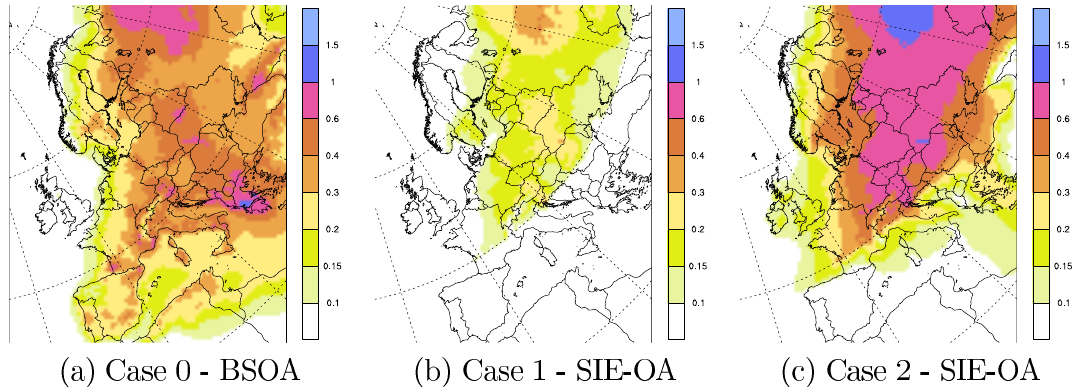
Figure 4. Model calculated 6-month mean (Apr–Sep) concentrations of BSOA and biotic stress-induced OA (SIE-OA); (a) BSOA in Case 0 (reference case without explicit stress-induced emissions), (b) SIE-OA in Case 1 (biotic stress with sesquiterpene (SQT) emissions), (c) SIE-OA in Case 2 (biotic stress with emissions of SQT and methyl salicylate). Unit: µgm − 3 .